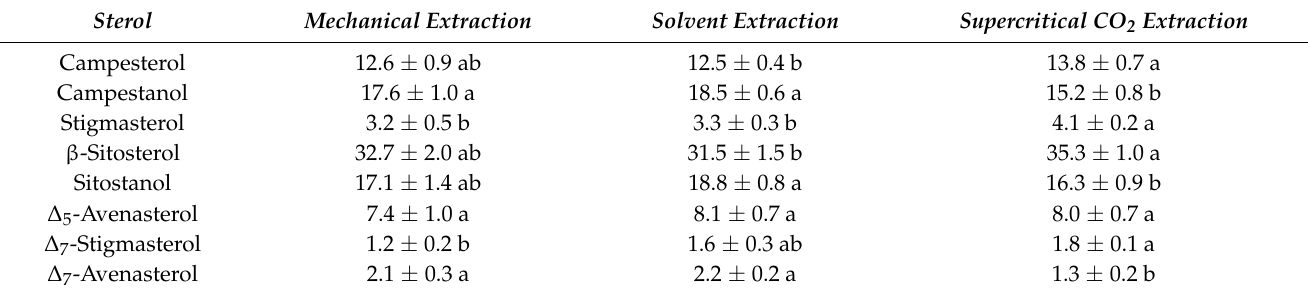
Table 5. Single sterol composition (%) of WGO extracted with different